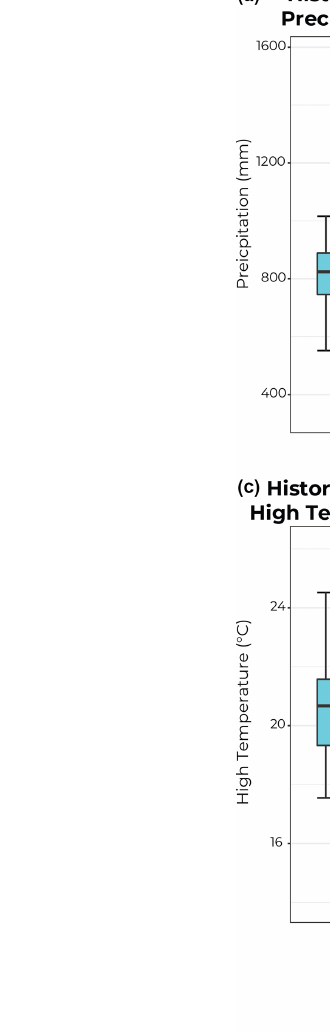
Figure 5. The unweighted model values across each of the three domains. Panels (a, c) show results during the historical period (1981–2005), and the raw ensemble is compared to the same values from the Livneh observations. Panels (b, d) show the 2070–2099 projected changes under RCP8.5 from both ensembles. Panels (a, b) are for precipitation, and (c, d) are for high